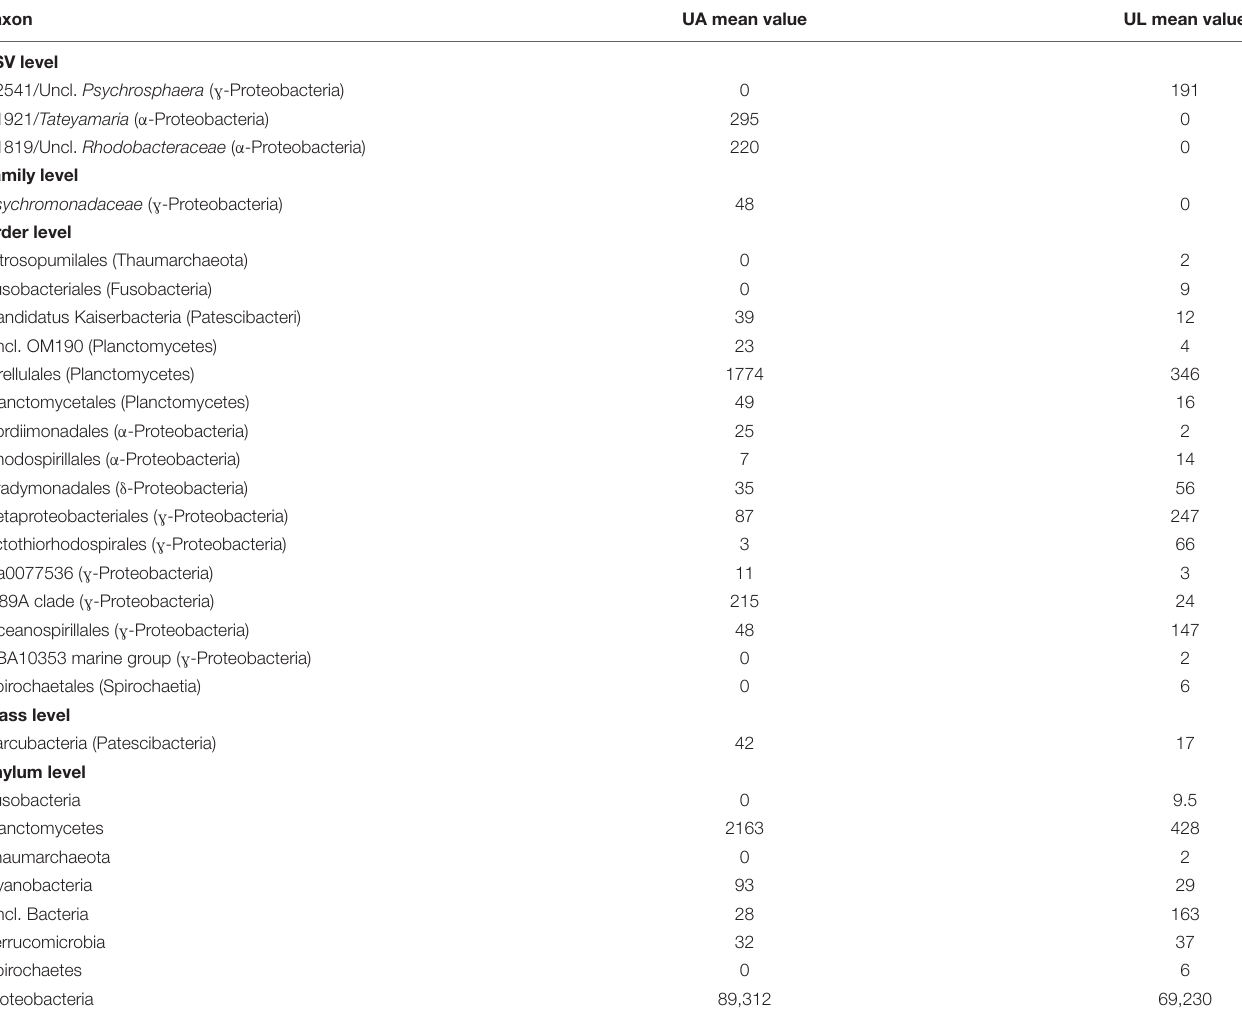
TABLE 4 | ANCOM analysis of the comparison within Ulva ’s microenvironments (UA, Ulva collected from aquaculture, versus UL, Ulva collected from the lagoon).